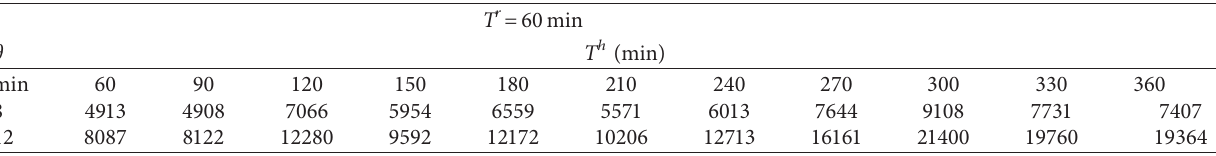
Figure 14: Results of network size with different buffer times. Table 5: The influence of buffer time on network size when the rolling horizon is 60